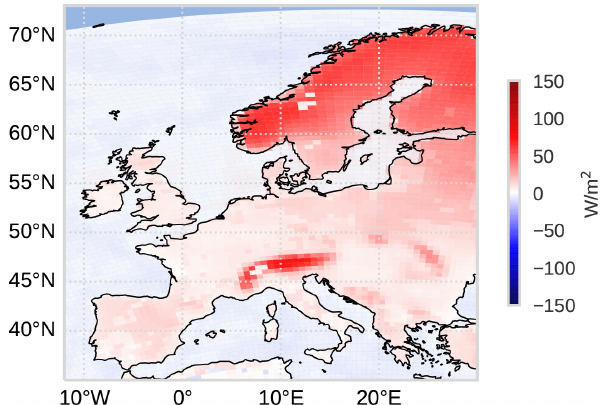
Figure 8. Mean differences in net shortwave radiation in spring between CARBON and GRASS for the period